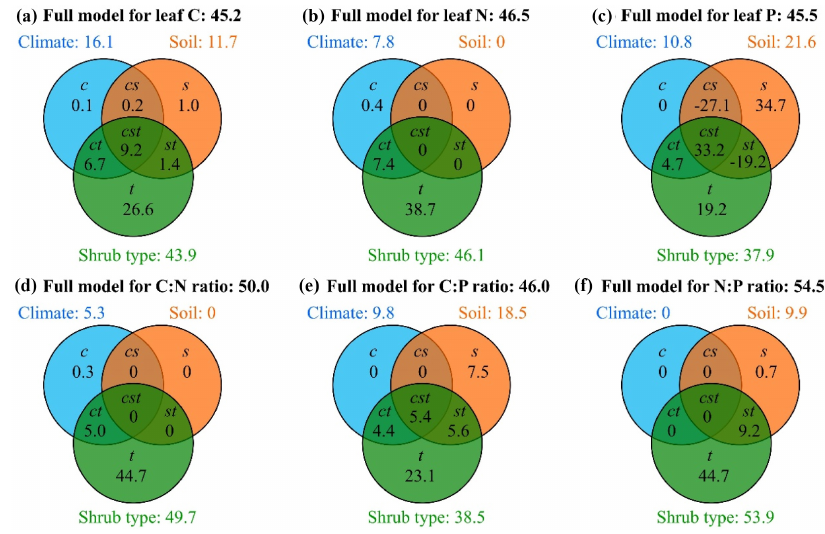
Figure 3. Summary of the partial general linear models (GLM) for the effects ( R 2 , %) of climate, soil and shrub type on leaf stoichiometry. c , s , and t represent the independent effects of climate, soil, and shrub type, respectively; cs , ct , and st are the interactive effects between climate and soil, climate and shrub type, soil and shrub type, respectively; cst denotes the interactive effect among the three factors. Leaf element concentrations and ratios were log 10 -transformed before analysis. Insignificant climatic or soil variables were not included in the partial GLM analysis. Shrub type stands for the combination of ecosystem type and functional type (e.g., montane deciduous broad-leaf